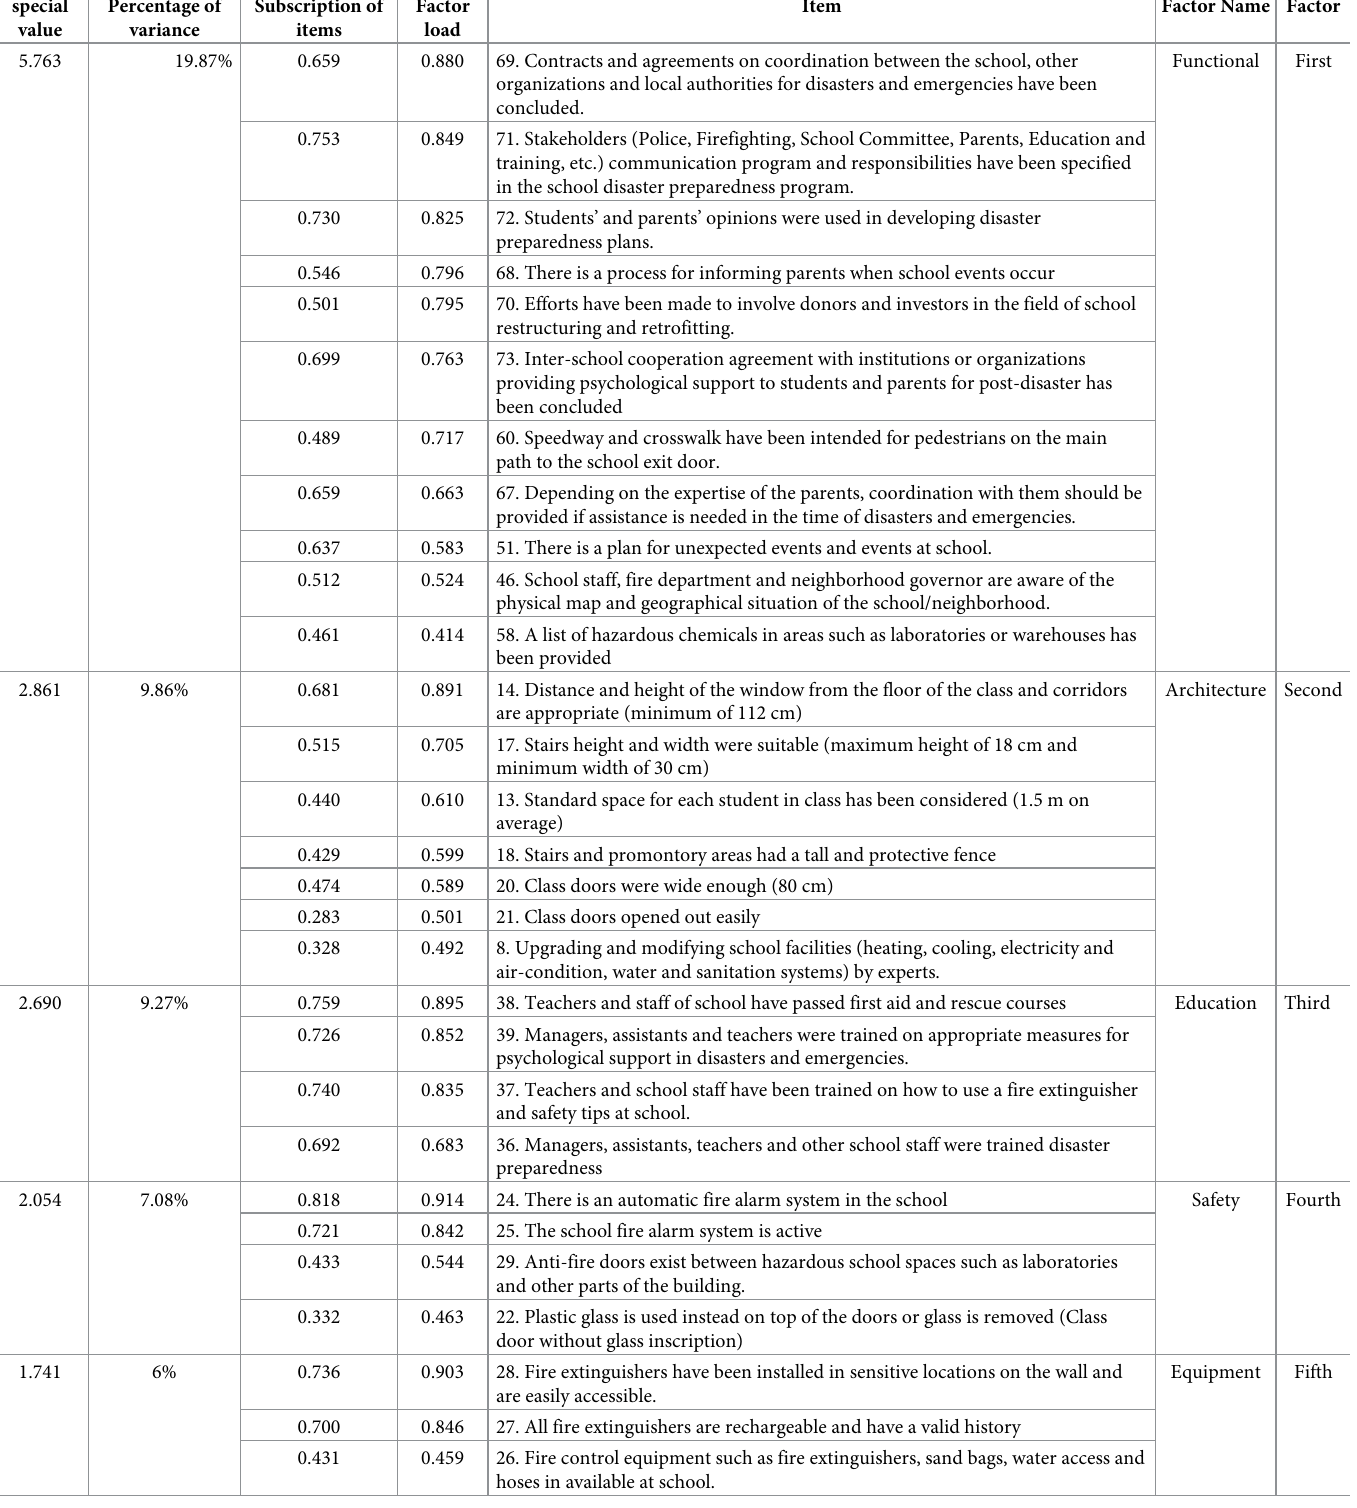
Table 1. Exploratory factors extracted from the questionnaire of school resilience in emergencies and disasters. special Percentage of value